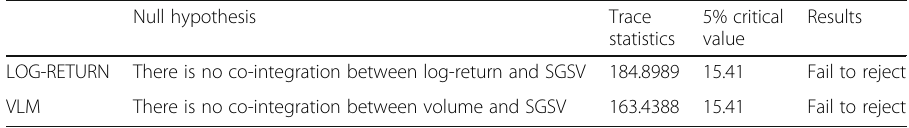
Table 3 Johansen Co-integration Test Null hypothesis Trace